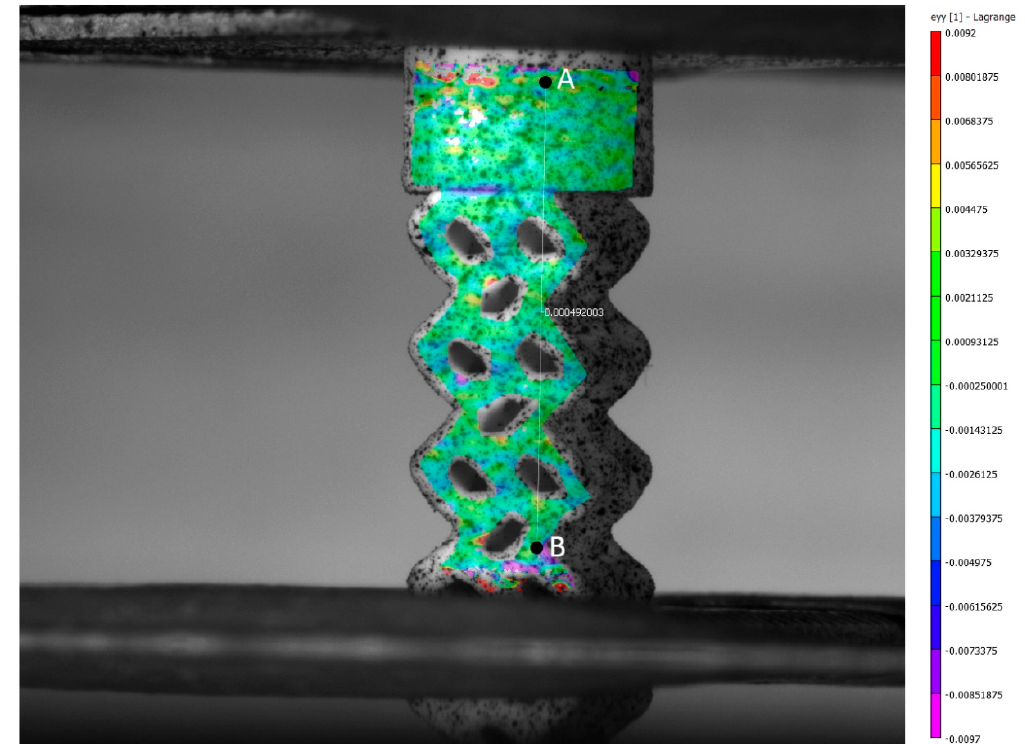
Figure 13. The distribution of vertical strains at the surface of the BI002 specimen during testing at the 187.5 N load, obtained by digital image correlation (DIC).